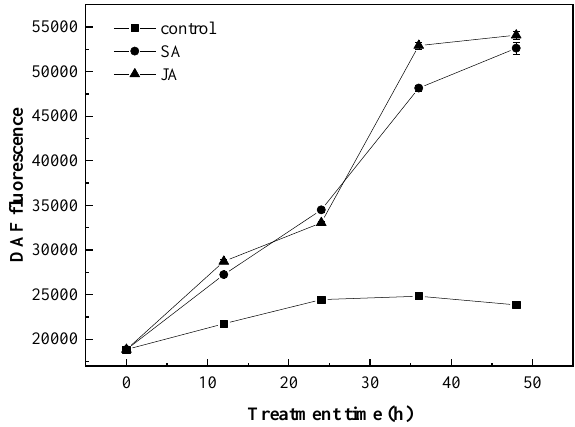
Figure 4. The NO content in N. flagelliforme under SA and JA induction.